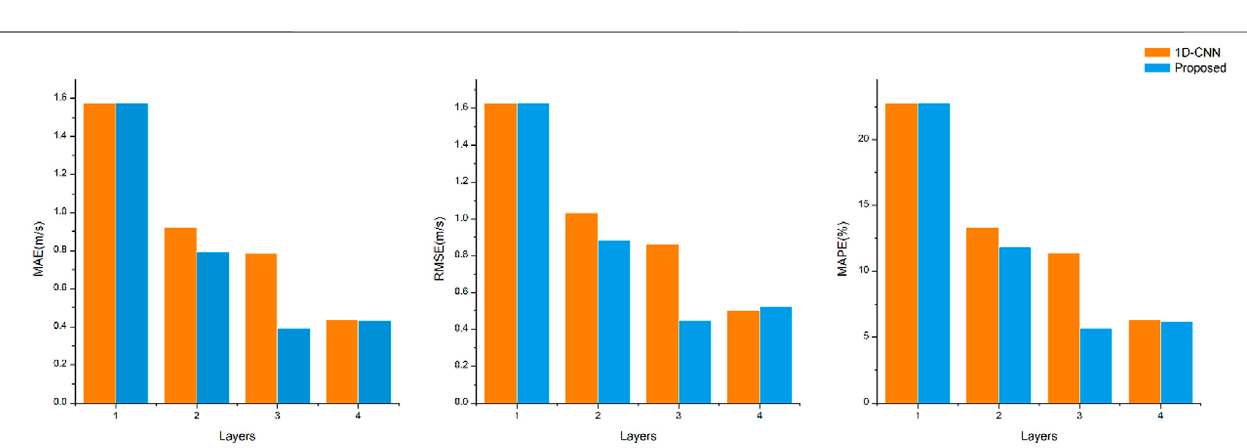
FIGURE 9 | Histogram of the prediction error of the two models under different convolutional layer structures.